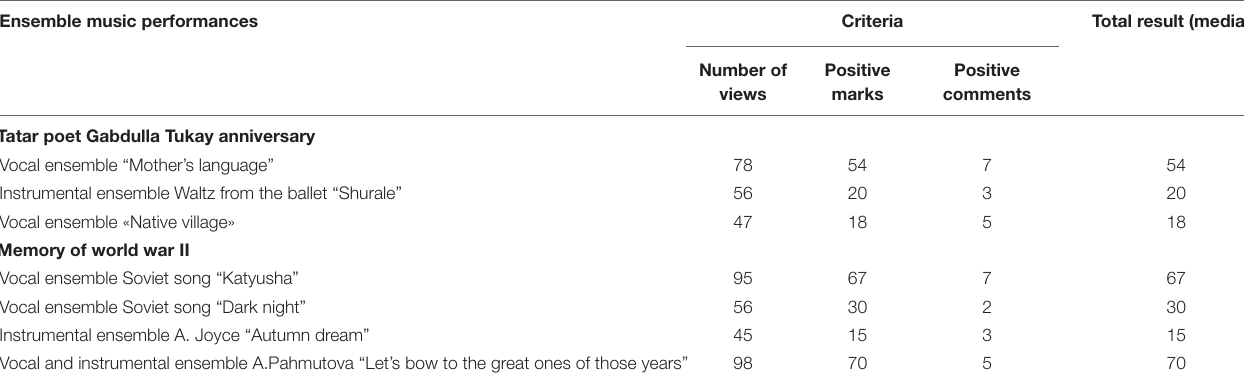
TABLE 6 | Social projects activity